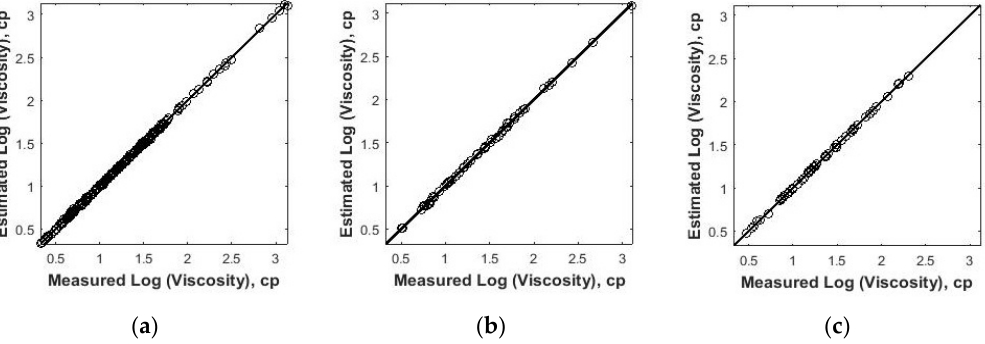
Figure 7. Comparison of the measured and estimated data for AN-125. ( a ) Training. ( b ) Validation. ( c ) Test.